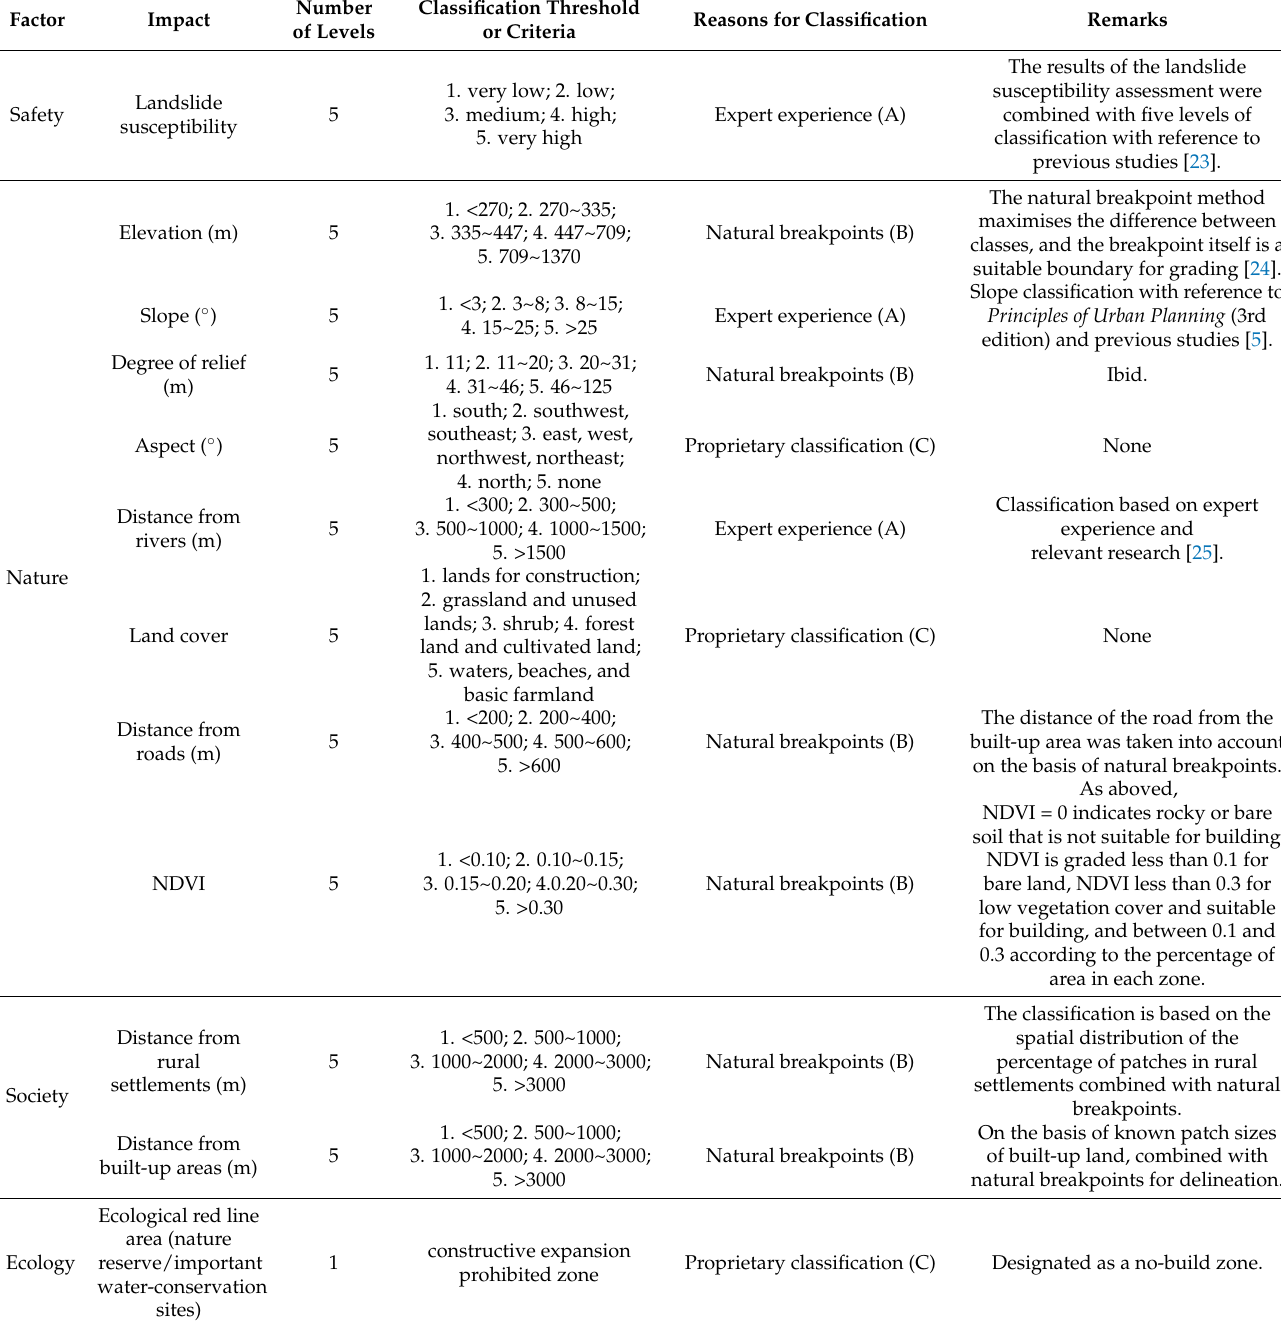
Table 3. Classification of contributing elements for construction land suitability